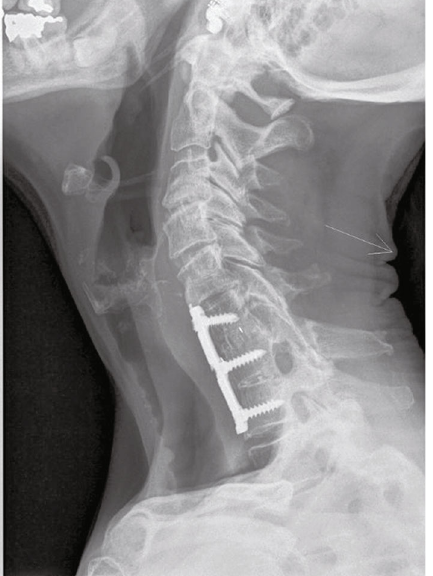
Figure 3: Postoperative X-rays (lateral view).